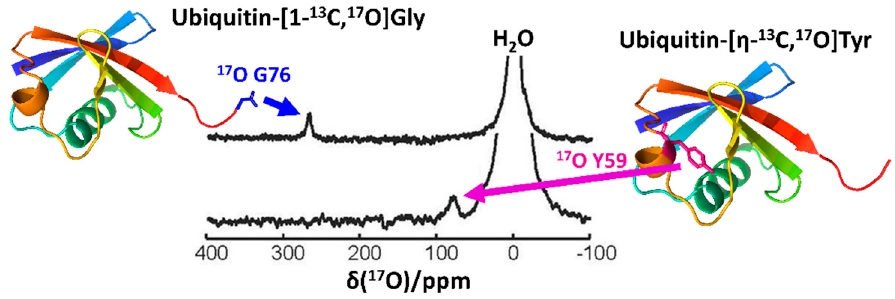
Figure 4. The solution-state 17 O NMR spectra of ubiquitin-[1- 13 C, 17 O]Gly (top) and ubiquitin-[ η - 13 C, 17 O]Tyr (bottom) measured at 16.4 T. The residues whose signals were observed in the corre- sponding spectra were noted in the structural model of ubiquitin (PDB 1UBQ). The figure was reproduced with permission from [20].